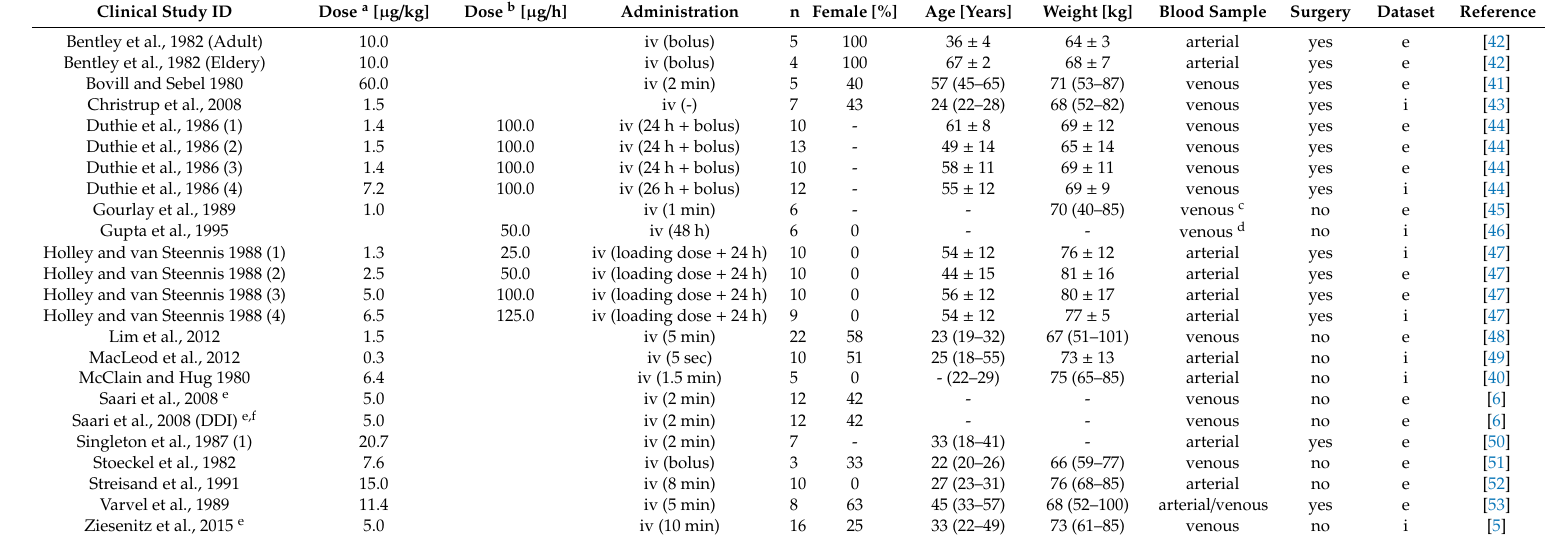
Table 1. Overview of clinical studies used for building and evaluation of the adult PBPK model of fentanyl and norfentanyl.